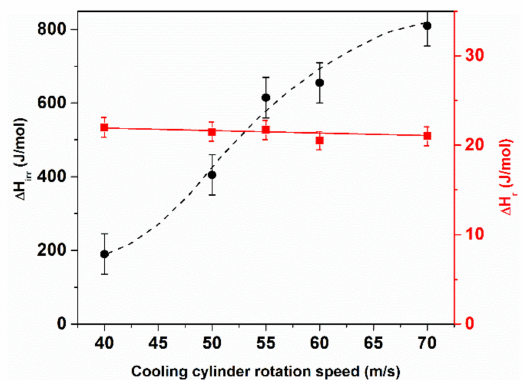
Figure 11. Comparison of irreversible ( ∆ H irr. ) and reversible ( ∆ H r. ) enthalpy relaxation (for ∆ H rev. the samples were annealed at 500 K for 60 min). Adopted from [74], with permission from Elsevier, 1988.